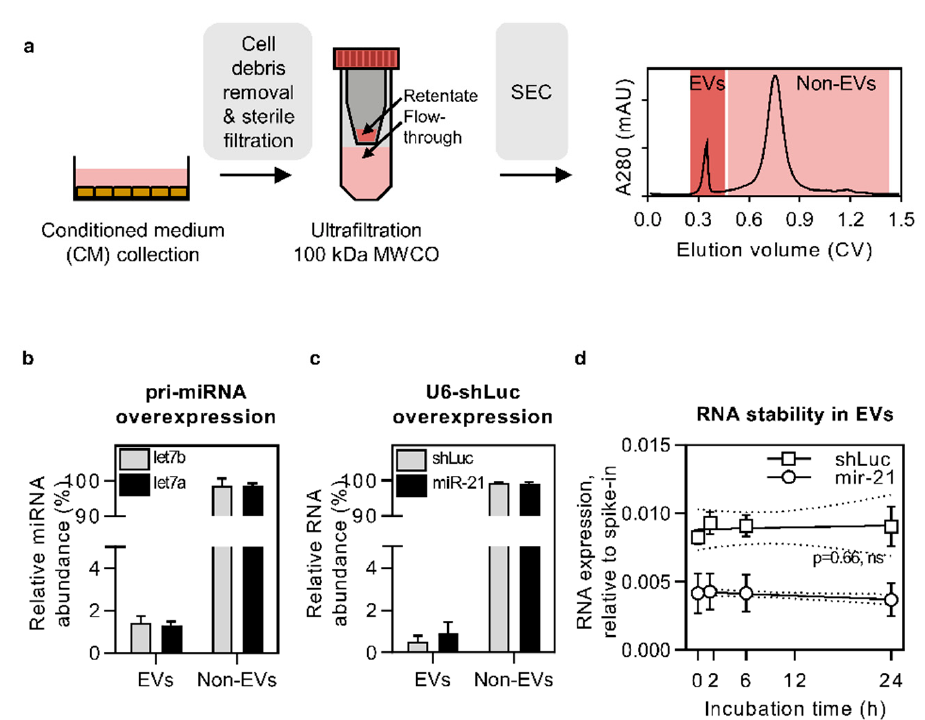
Figure 1. EV isolation workflow and the secretory distribution and stability of overexpressed miRNAs. ( a ) HEK293T (HEK) cells and hTERT-MSCs (MSCs) were seeded to 15 cm tissue culture plates.